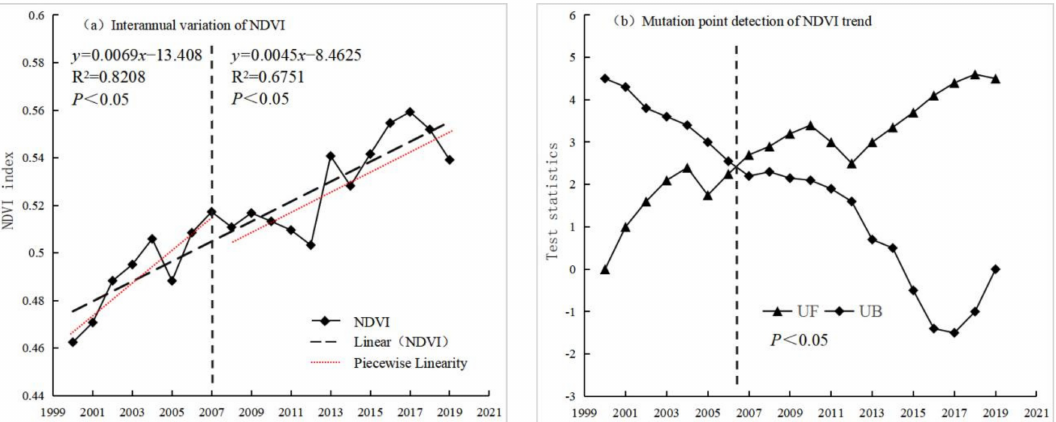
Figure 3. Interannual variation trend and mutation point detection of NDVI of vegetation in the Yangtze River Basin from 2000 to